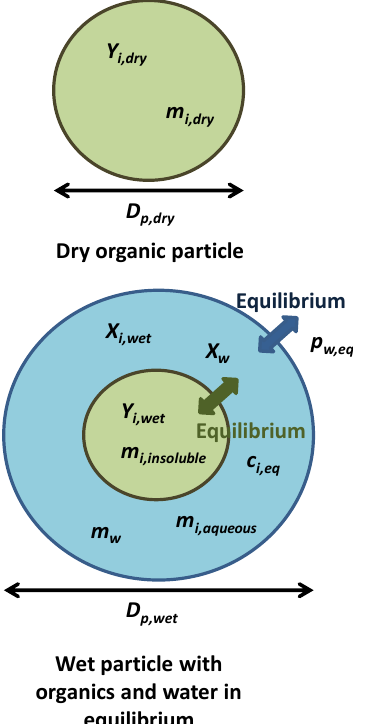
Figure 1. Schematic of the conceptual model used in the equilib- rium composition calculations. The dry particle is assumed to con- sist of n organic compounds, each denoted with a subscript i . The wet particle is assumed to consist of a dry organic (insoluble) phase and an aqueous phase with water and dissolved organics. The aque- ous phase is assumed to be in equilibrium with the ambient water vapor. Y refers to mole fractions in the organic phase, X to mole fractions in the aqueous phase, and m to the masses of the organic constituents and water. c i, eq refers to the equilibrium concentration of each organic compound in the aqueous solution and p w , eq to the equilibrium vapor pressure of water above the aqueous